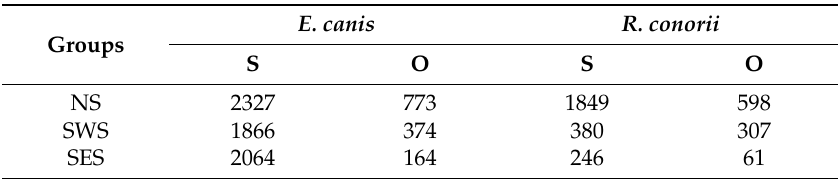
Table 1. Sample categories according to geographic areas defined in the study: Northern Sicily (NS), South Western Sicily (SWS), South Eastern Sicily (SES) and dogs’ population, shelter dogs (S) and owned dogs (O).